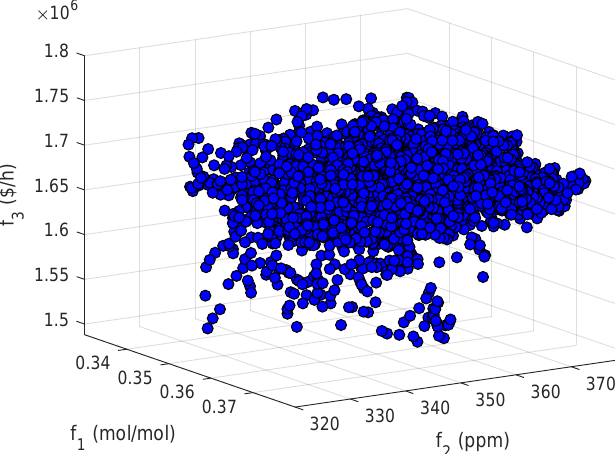
Figure 7. Distribution of objective values corresponding to data for modeling.